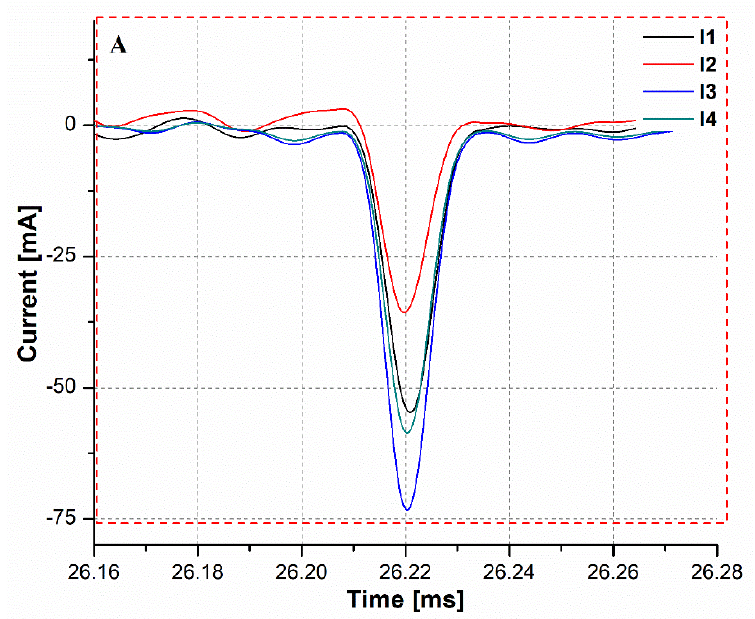
Figure 10. CCL-type NTP multi-reactor current waveforms—zoomed-in view on one set of current pulses.